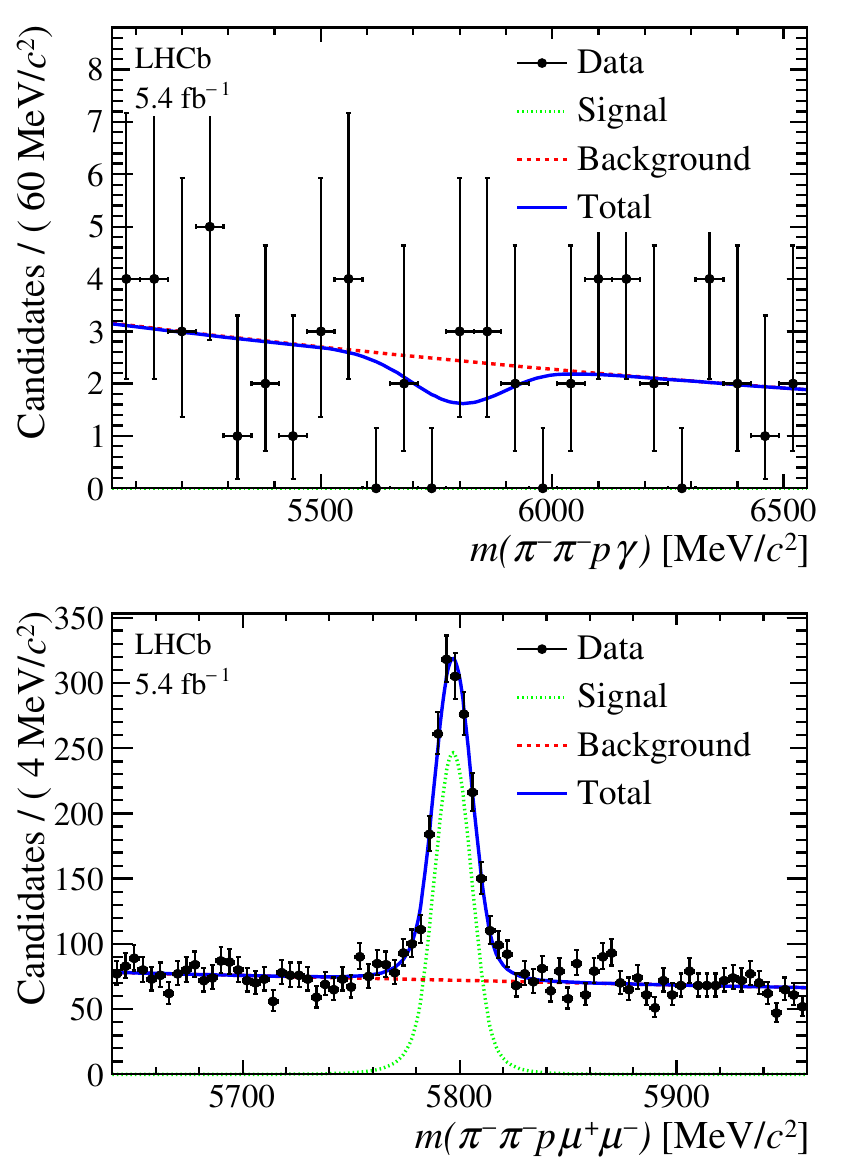
Figure 4 . Distribution of (top) mass m ( π − π − pγ ) for selected Ξ − γ ( Ξ − → Λπ − ) and (bottom) m ( π − π − pµ + µ − ) for selected Ξ − J/ψ ( J/ψ → µ + µ − ) candidates. The projections of the simultaneous fit are